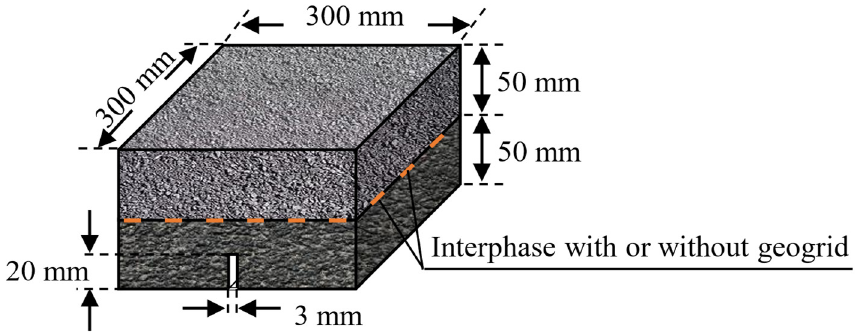
Figure 2. Geometrical configuration of the test sample.